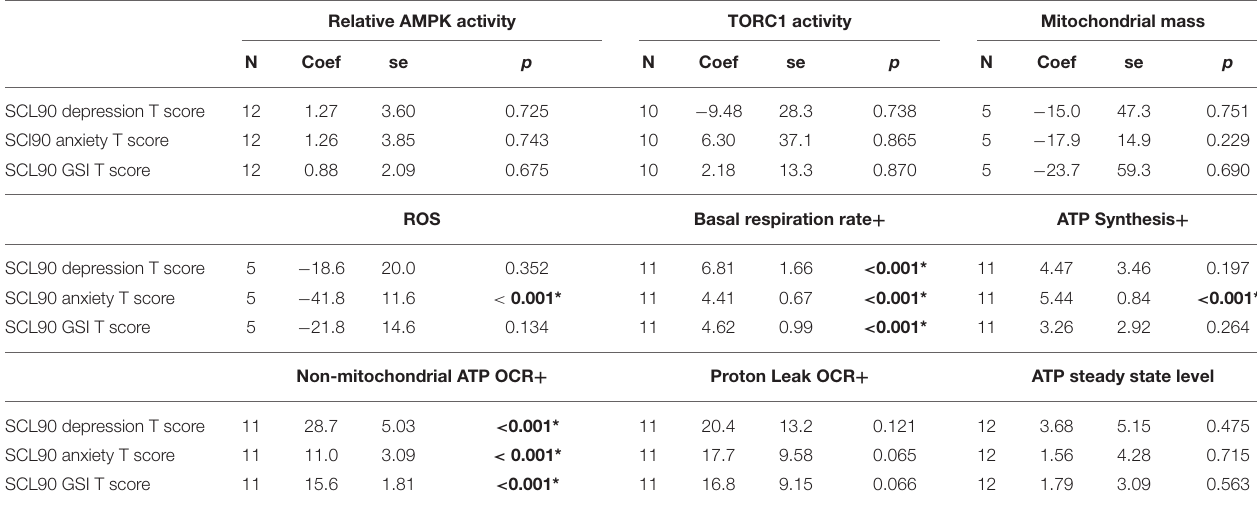
TABLE 3B | Relationships between SCL90 scores and cellular stress sensing and bioenergetics measures in FXTAS sample. Relative AMPK activity TORC1